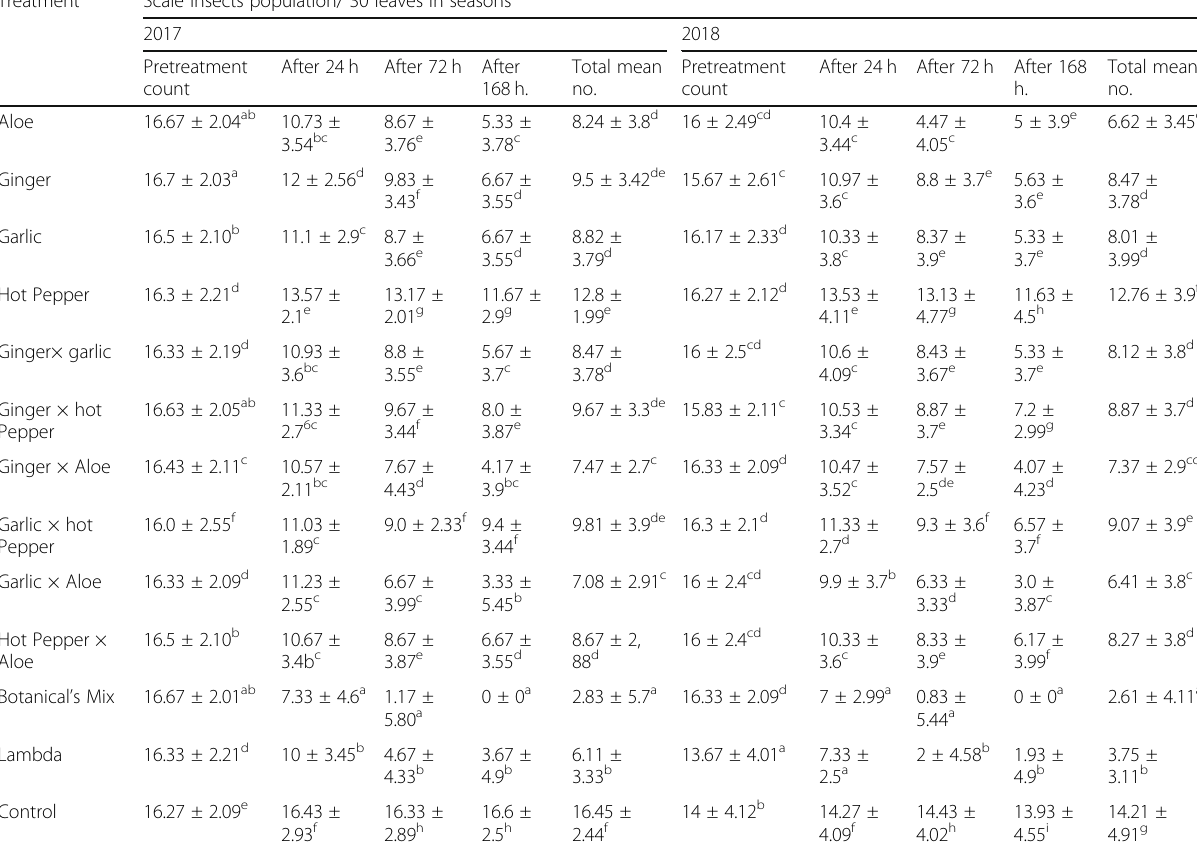
Table 1 Population of scales pre- and post-treatments in seasons 2017 and 2018 at Fayoum Governorate Treatment Scale insects population/ 30 leaves in seasons